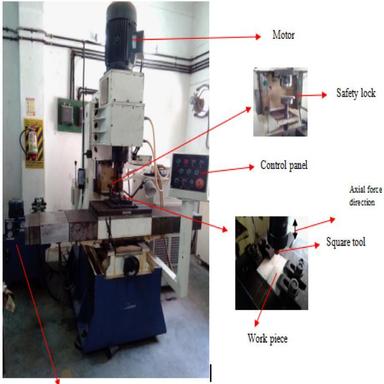
FSW machine.